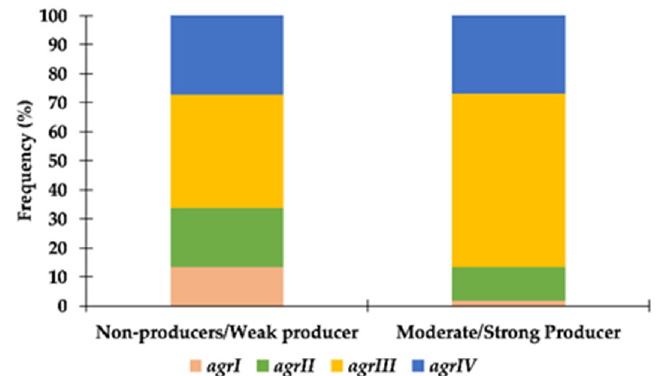
Figure 2. Distribution of S. pseudintermedius strains according to their agr type and capacity to produce biofilm.